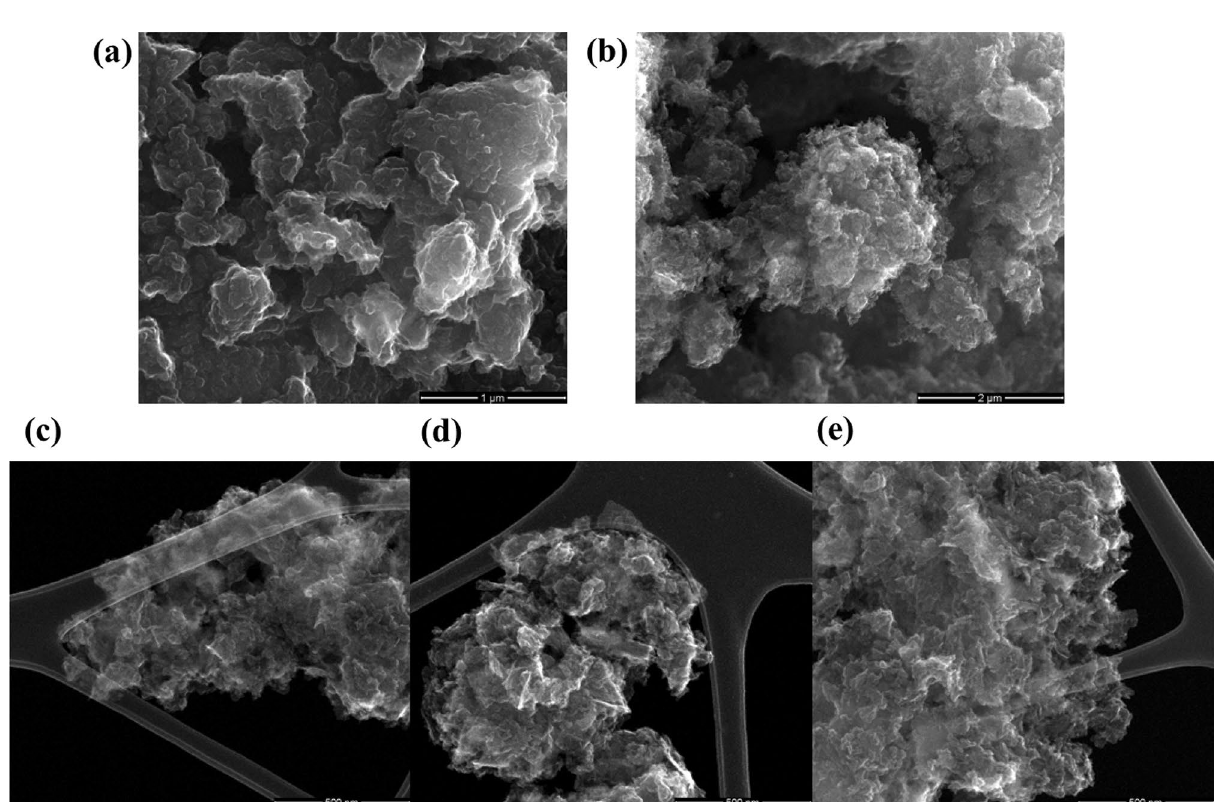
Figure 5. SEM images of samples ( a ) GF-750, ( b ) G-800, and in the STEM mode ( c ) G-700, ( d ) G-800 and ( e )